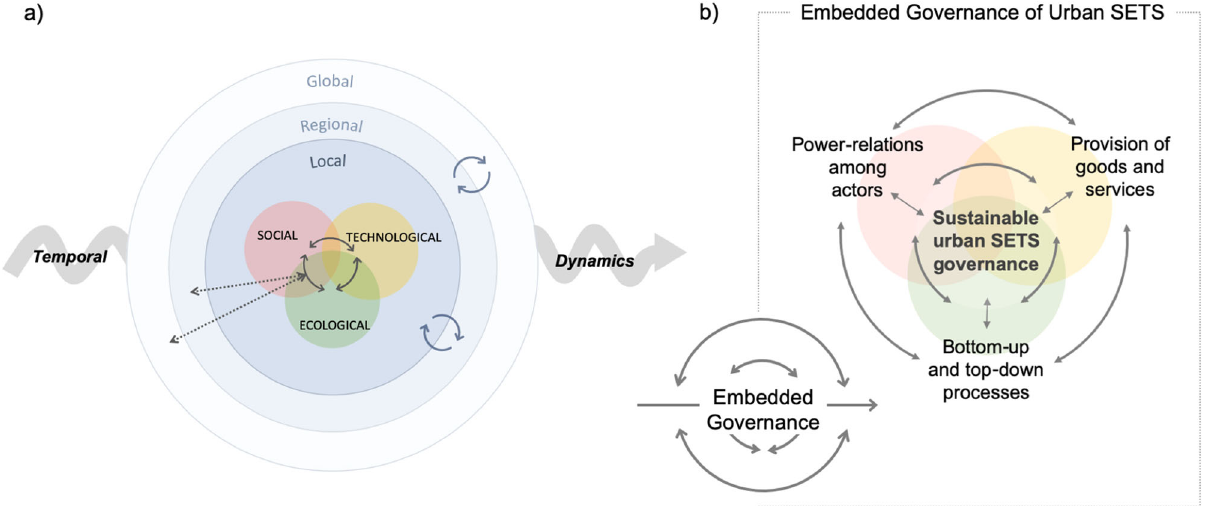
Fig. 1 Governance of Urban Social-Ecological-Technological Systems. a Dependencies across time and space. Shocks and stressors have the potential to impact one or all elements of the SETS across spatial scales, and determine the evolution of the urban system (arrow ‘ Temporal Dynamics ’ ). Figure adapted from 175 . b Embedded Governance: Embedded actors and SETS elements interact to shape the governance of urban SETS, negotiate the interfaces of the SETS elements, and coordinate transformation processes towards sustainability across spatial and temporal scales. We focus on three interacting elements of particular importance: (1) Equitable and reliable access to resources in urban areas ( ‘ Provision of goods and services ’ ). These are an important basis for urban livelihoods and for inclusive social, economic, and political processes to take place. (2) The interactions of bottom-up processes and economic activities with top-down efforts by government actors ( ‘ Bottom-up and top-down processes ’ ). A balance between ‘ top-down ’ and ‘ bottom-up ’ dynamics can enable local innovation and experimentation to result in systemic transformations. (3) ‘ Power-relations among actors ’ determine the choice of policies, the distribution of resources and social in fl uence, and thus, the trajectories of urban SETS. Arrows in ( a ) and ( b ) represent the embeddedness of